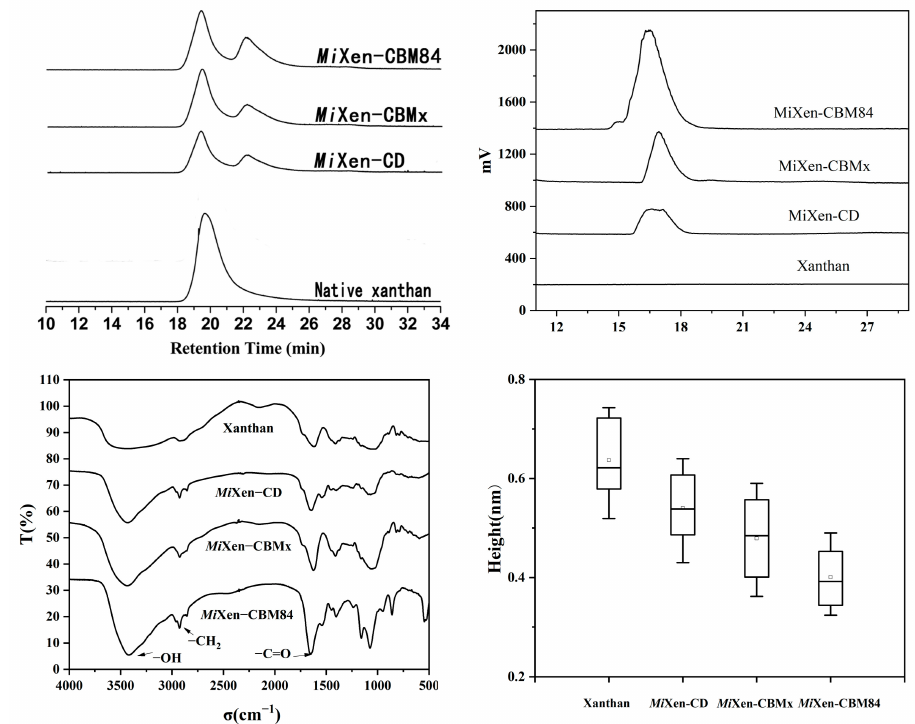
Figure 7. Analysis of xanthan hydrolysates. ( a ) Gel permeation chromatography elution patterns of xanthan and xanthan digests. ( b ) Liquid chromatography analysis of the degree of polymerization of hydrolyzed xanthan. ( c ) Infrared spectroscopic analysis of xanthan and its hydrolysates. ( d ) Boxplots of the measured heights of xanthan and xanthan hydrolysates ( n = 20 for